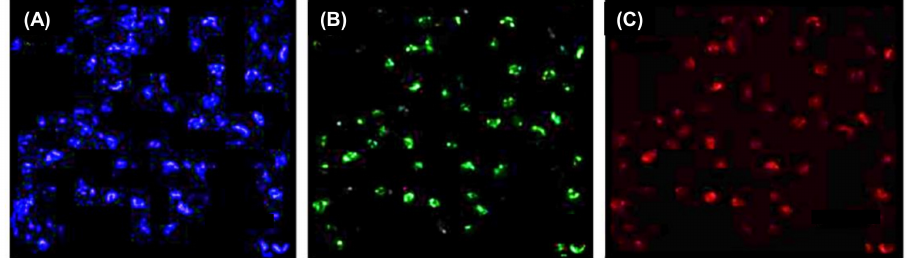
Figure 22. Bioimaging of HeLa cells. ( A ) Blue emission at 405 nm excitation. ( B ) Green emission at 458 nm excitation. ( C ) Red emission at 514 nm excitation